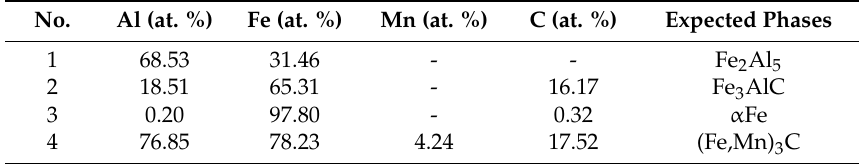
Figure 9. STEM results showing of FIB specimen extracted from area denoted by X 2 in Figure 8: ( a ) HAADF Image. ( b – f ) Results of EDS: ( b ) Al; ( c ) Ni; ( d ) Fe; ( e ) Mn; ( f ) C. Table 3. EDS analysis results and expected phases in the area indicated by 1–4 in Figure 7a.